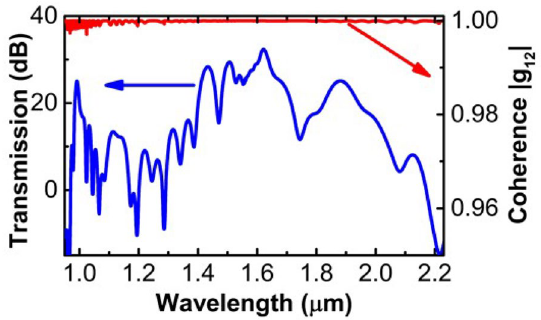
Figure 4. Simulated SCG spectrum (blue) and spectral coherence | g 12 | (red) by adding one-photon-per-mode noise using 500 fs pulses with a pulse energy of 17